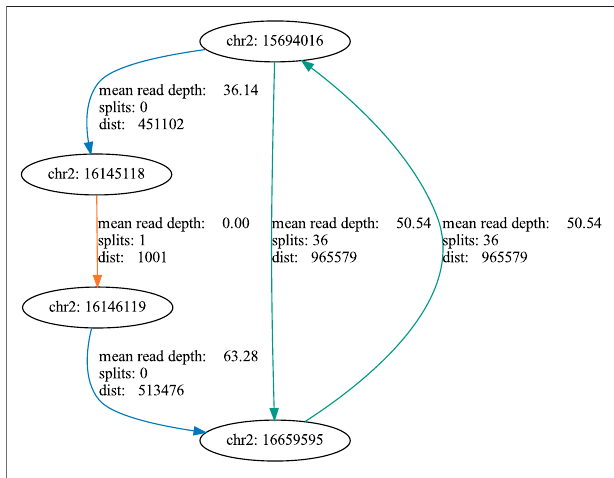
FIGURE 8 | Graph of an extracellular amplicon encompassing the MYCNoncogeneinthecelllineKelly.blue: coverage edge,orange:splitedge, green: coverage + split